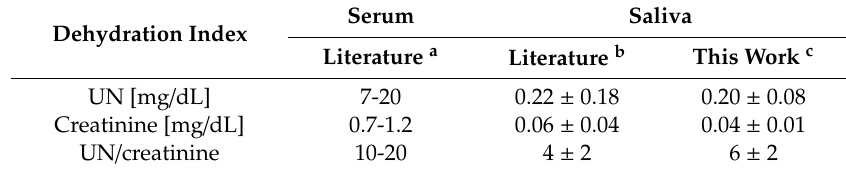
Table 3. Reference values for urea nitrogen (UN), creatinine and the ratio UN / creatinine in serum and saliva.